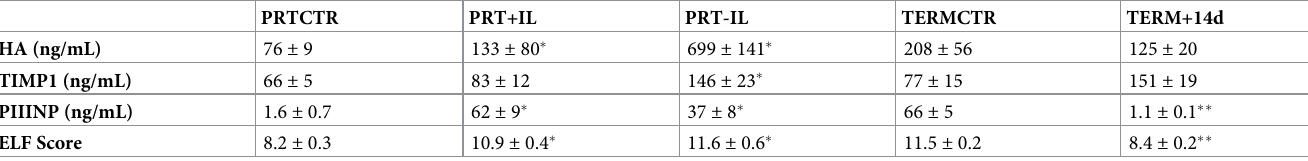
Table 2. Serum markers of liver fibrosis in infant